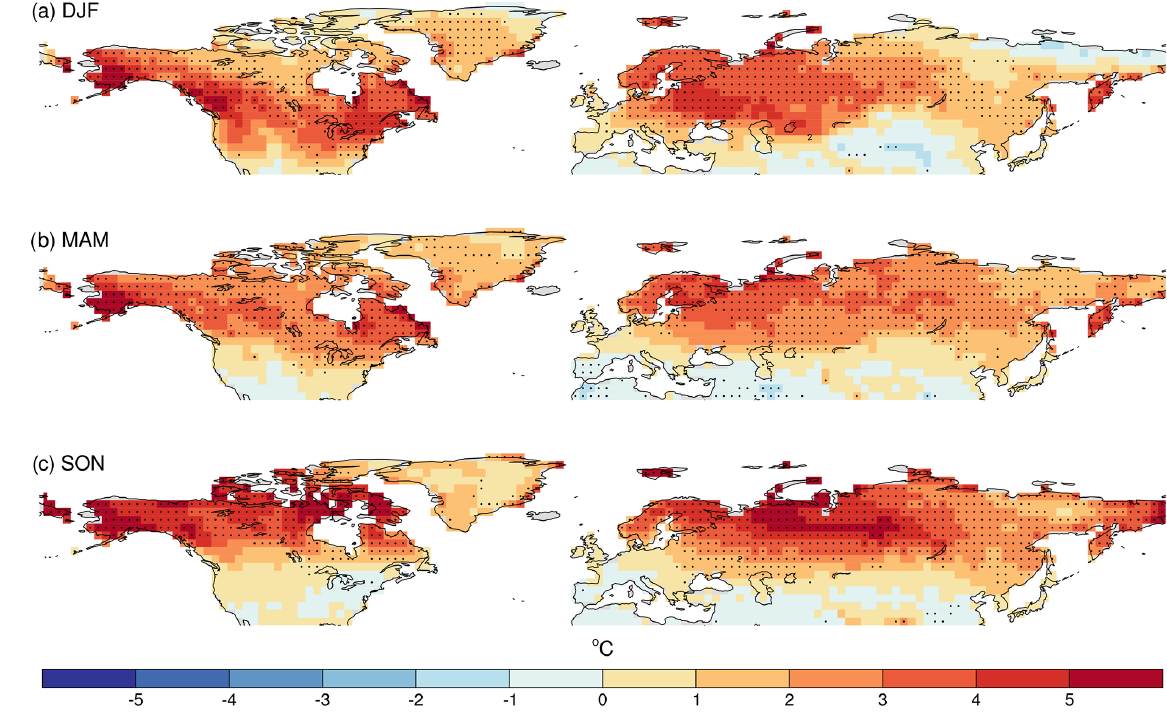
Figure 2. Future excess changes (2070–2099 to 1950–1979) in cold extremes (seasonal minima – seasonal mean) in the six-member CMIP5 multi-model mean for boreal winter (a) , spring (b) and autumn (c) . Stippling indicates grid cells that are both significant at the 5% level as assessed by a KS test and where at least five out of six models agree on the sign of excess